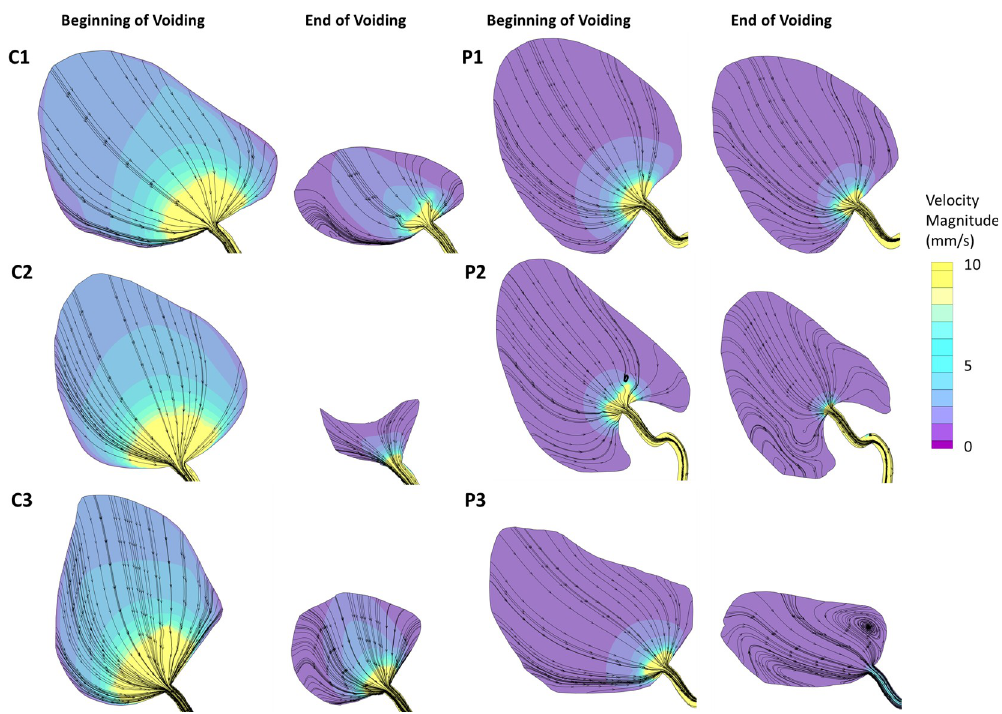
Fig 6. CFD results showing velocity contours and streamlines on a sagittal plane at the center of the bladder for each subject. Time points are displayed both near the initiation and termination voiding.